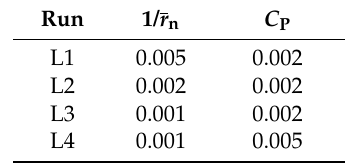
Table 2. Parameters used for living